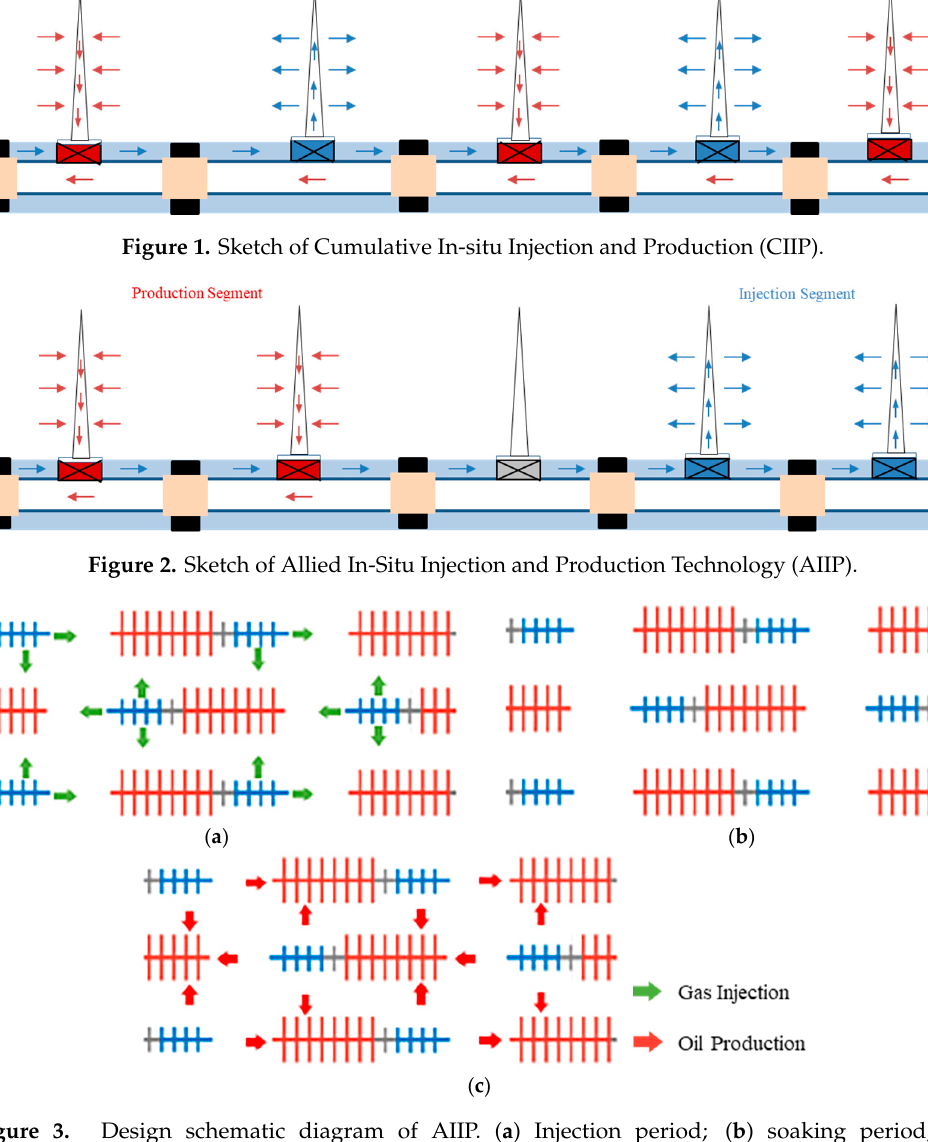
Figure 3. Design schematic diagram of AIIP. ( a ) Injection period; ( b ) soaking period; ( c ) production period.